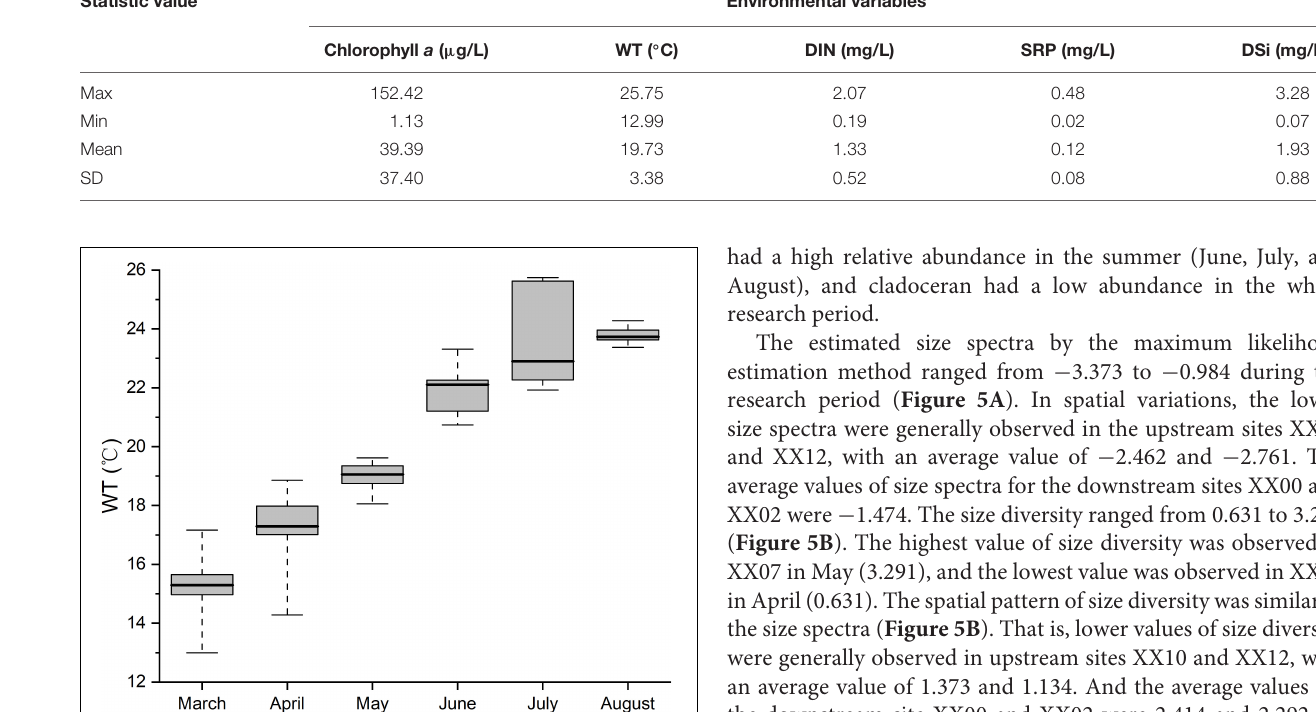
upstream of the bay ( Figure 3A ). The average concentration of DIN in the mouth (XX00) and upstream (XX12) were 1.65